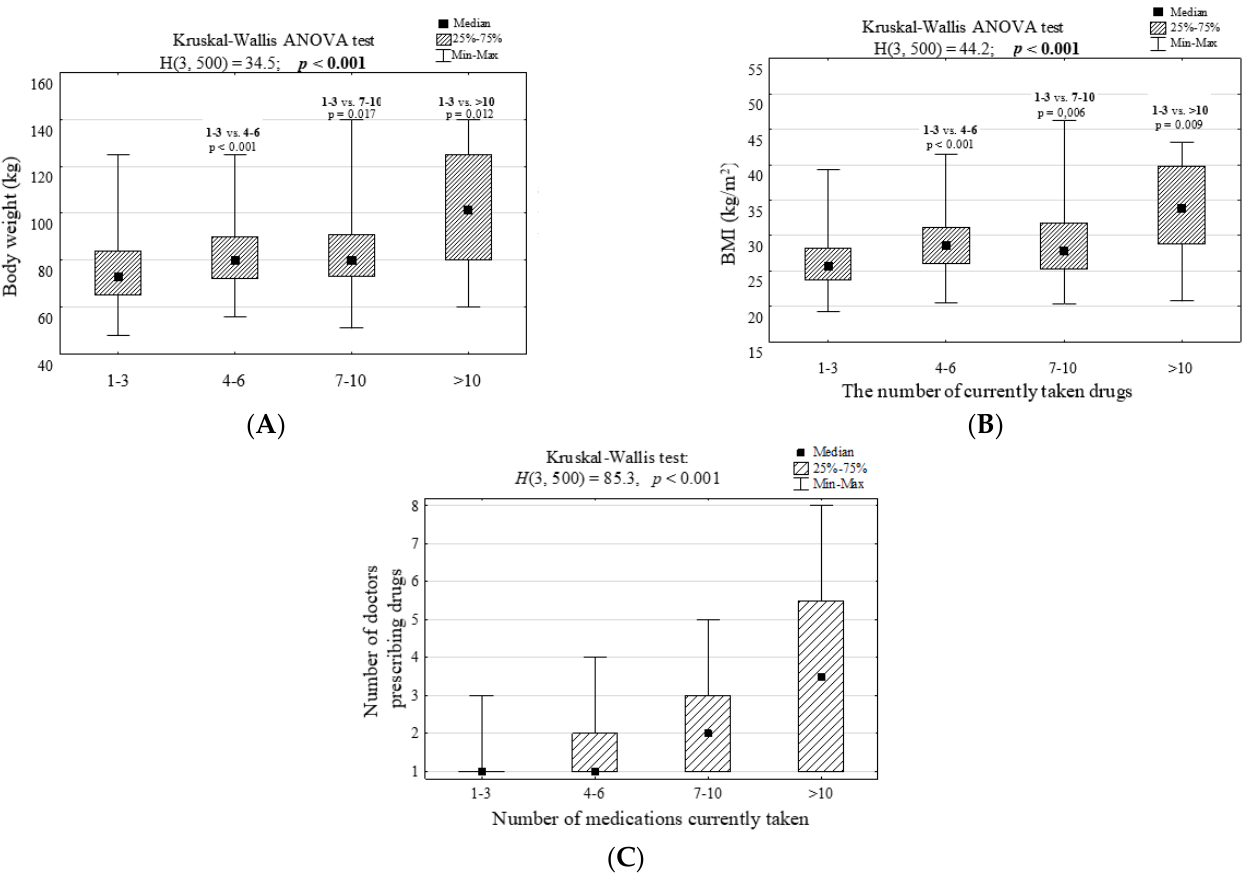
Figure 1. ( A ) Body weight, ( B ) body mass index and ( C ) number of doctors prescribing medicines to people differing in the number of currently taken medications and the results of significance tests.